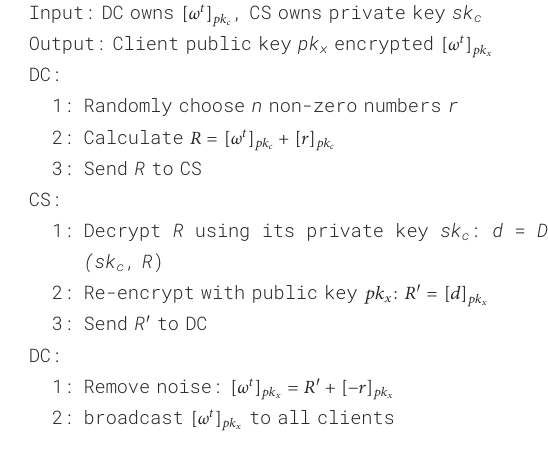
Algorithm 3. Global Model Safe Broadcast